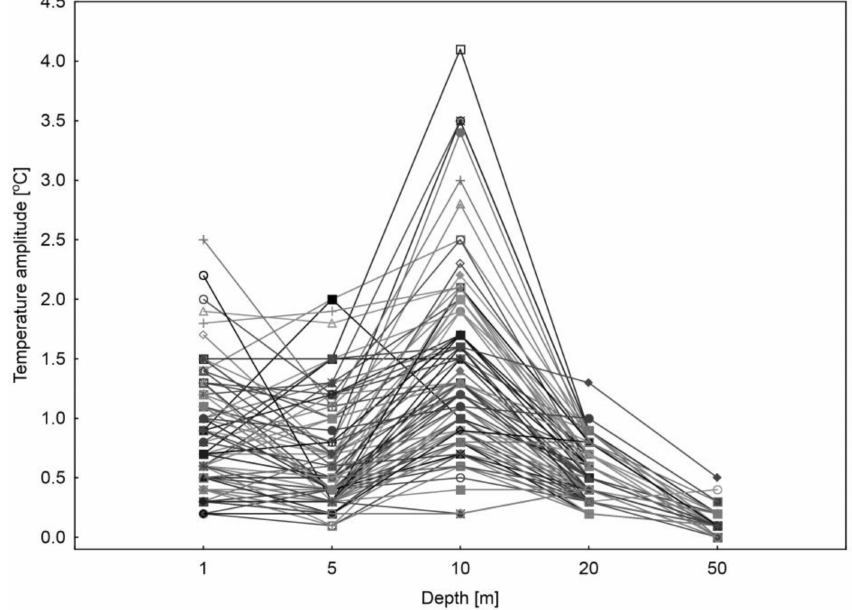
Figure 9. Correlation between water temperature amplitude and depth in Lake Morskie Oko. Temperature profile Type 4. The dates for each line are described in detail in the text